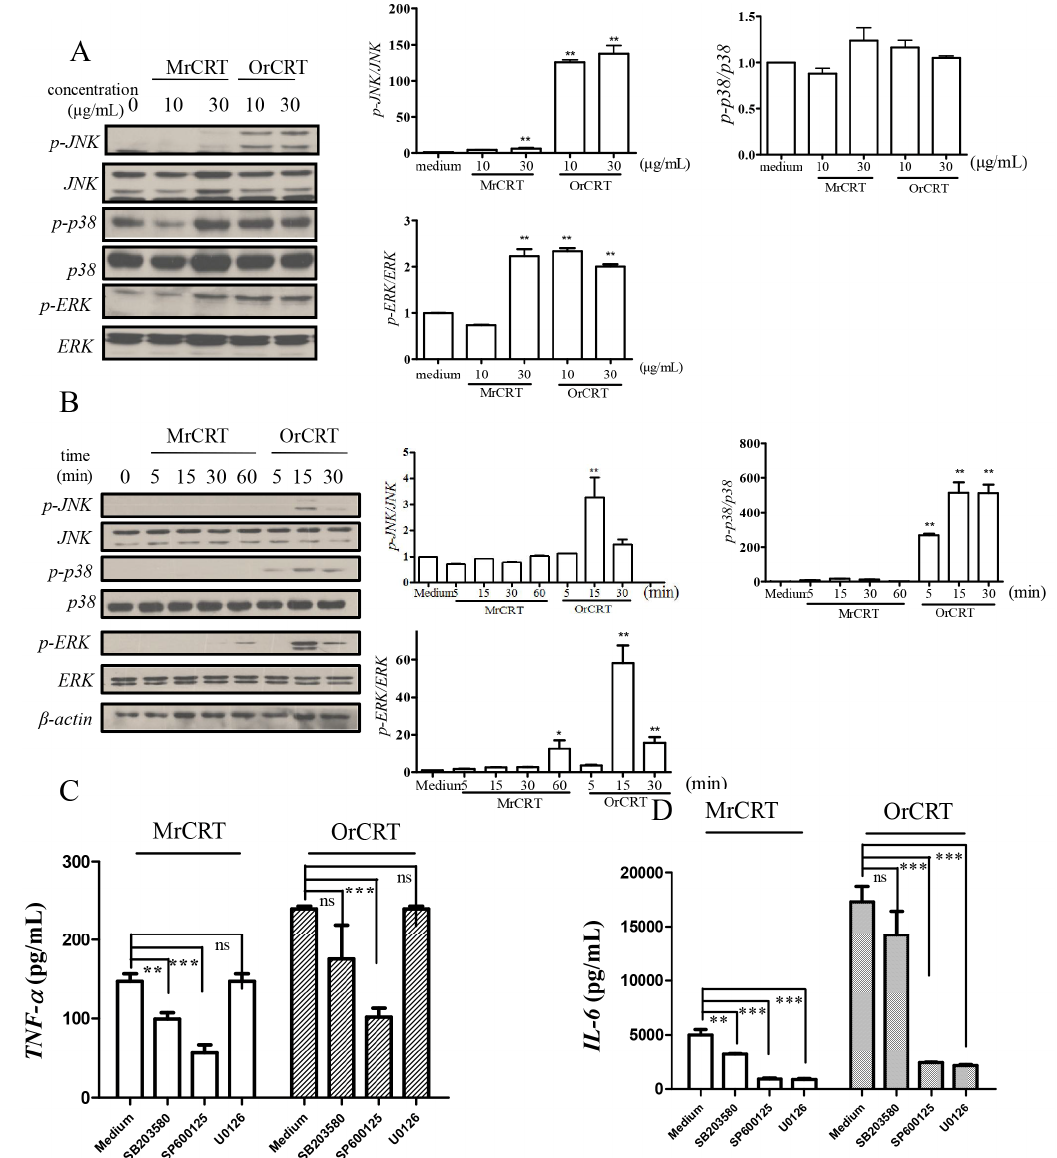
( A , B ) MAPK activation in macrophages stimulated with various concentrations of MrCRT or OrCRT for 30 min ( A ), or with 10 μ g/mL MrCRT or OrCRT for different time periods ( B ). Cell lysates were analyzed by SDS-PAGE and immunoblotted for total MAPK and phophorylated MAPK . Semi-quantitative densitometric analysis of Western blots was shown in the right panels; ( C , D ) The involvement of MAPK in rCRT-induced TNF- α and IL-6 production. Macrophages were pretreated with 30 μ M SB203580, SP600125 and U0126, and then stimulated with 10 μ g/mL MrCRT or OrCRT for 24 h. TNF- α ( C ) and IL-6 ( D ) in supernatant were quantitated by ELISA. * p < 0.05, ** p < 0.01, *** p < 0.005 vs . Medium alone